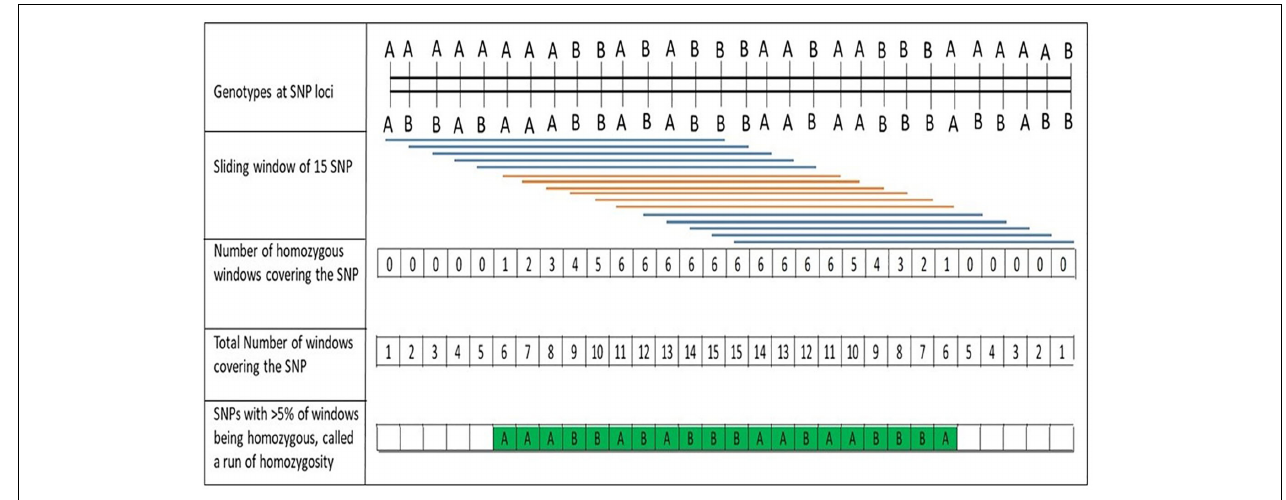
FIGURE 1 | Description of the process for discovery of runs of homozygosity (ROH) using a sliding window of single nucleotide polymorphisms (SNPs) along the chromosome, as implemented with PLINK software (Purcell et al., 2007; Bjelland et al.,